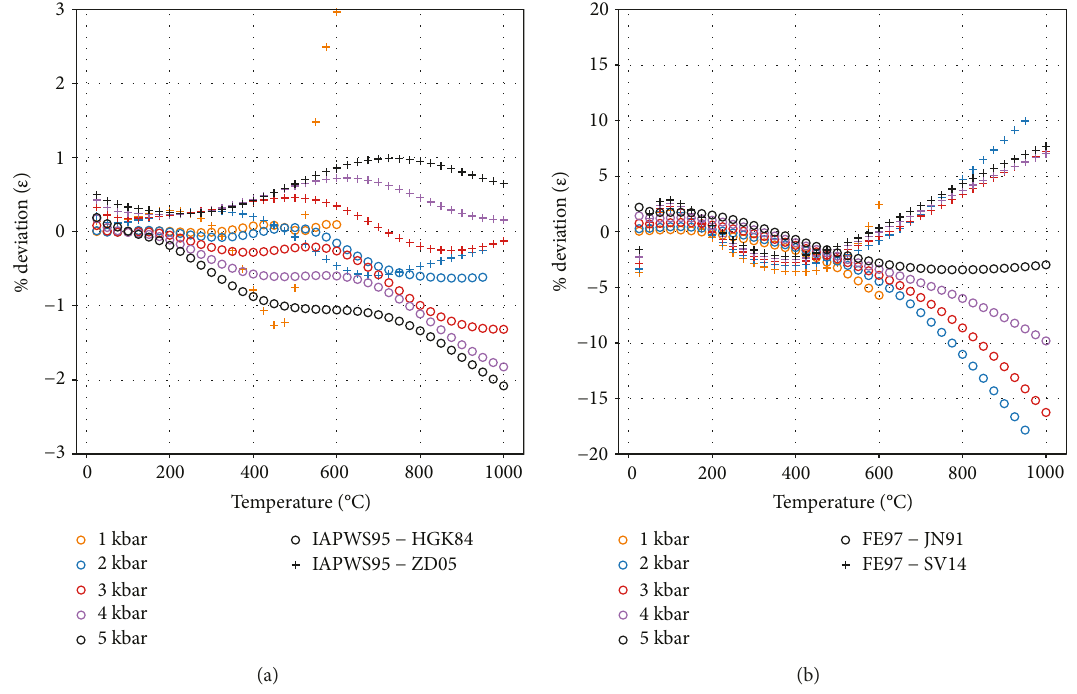
Figure 2: (a) Di ff erences in ε values (in %), obtained from the FE97 model, when using the HGK84 and ZD05 models for calculating ρ H 2 O values calculated with the JN14 and SV14 models from those compared to using the IAPWS95 model for water density. (b) Deviation of ε H 2 O obtained using the FE97 model; the IAPWS95 model used for ρ H 2 O